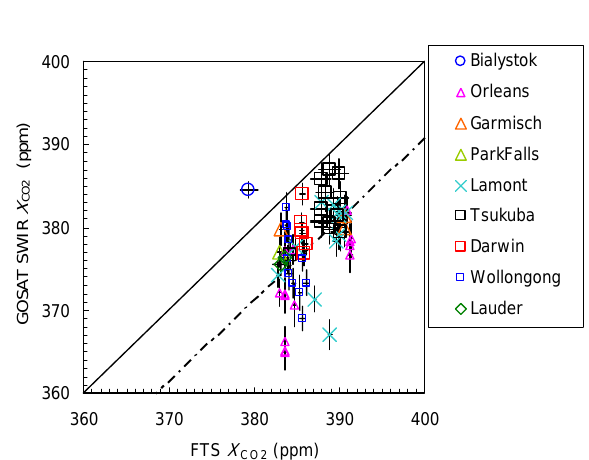
Fig. 5. Scatter diagram between GOSAT TANSO-FTS SWIR and g-b FTS X CO at all FTS sites. 2